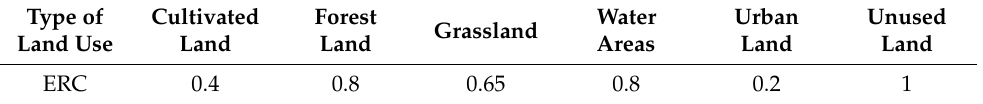
Table 2. The ecosystem resilience coefficients (ERCs) of land-use types in the GBA. Type